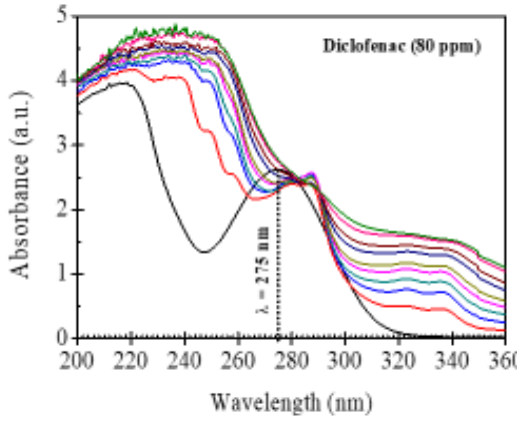
Figure 8. Photolysis of diclofenac using UV light irradiation without any photocatalyst.